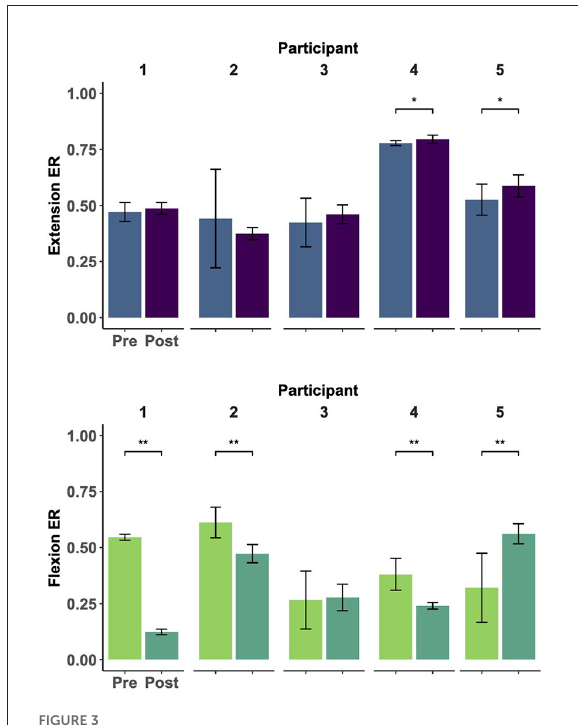
FIGURE3 Muscle group individuation during EMG amplitude control (ramp-and-hold tracking tasks). Each panel represents the individual changes (Participants 1–5, left to right) of muscle group individuation [quantified as the ratio of extensor to total activity (ER)] at constant levels of extension (top) and flexion (bottom) tracking before and after 30 EMG training sessions. Notably, remote EMG training sessions did not require a constant level of EMG activation and did not provide explicit error-based feedback. ER values closer to 1 indicate higher extensor activity whereas values closer to 0 indicate higher flexor activity. Improvements were seen in individuated recruitment for both tracking tasks (e.g., higher individuation and lower variability). * indicates a significance of p < 0.05, ** indicates significance of p < 0.001. Statistical results can be seen in Table